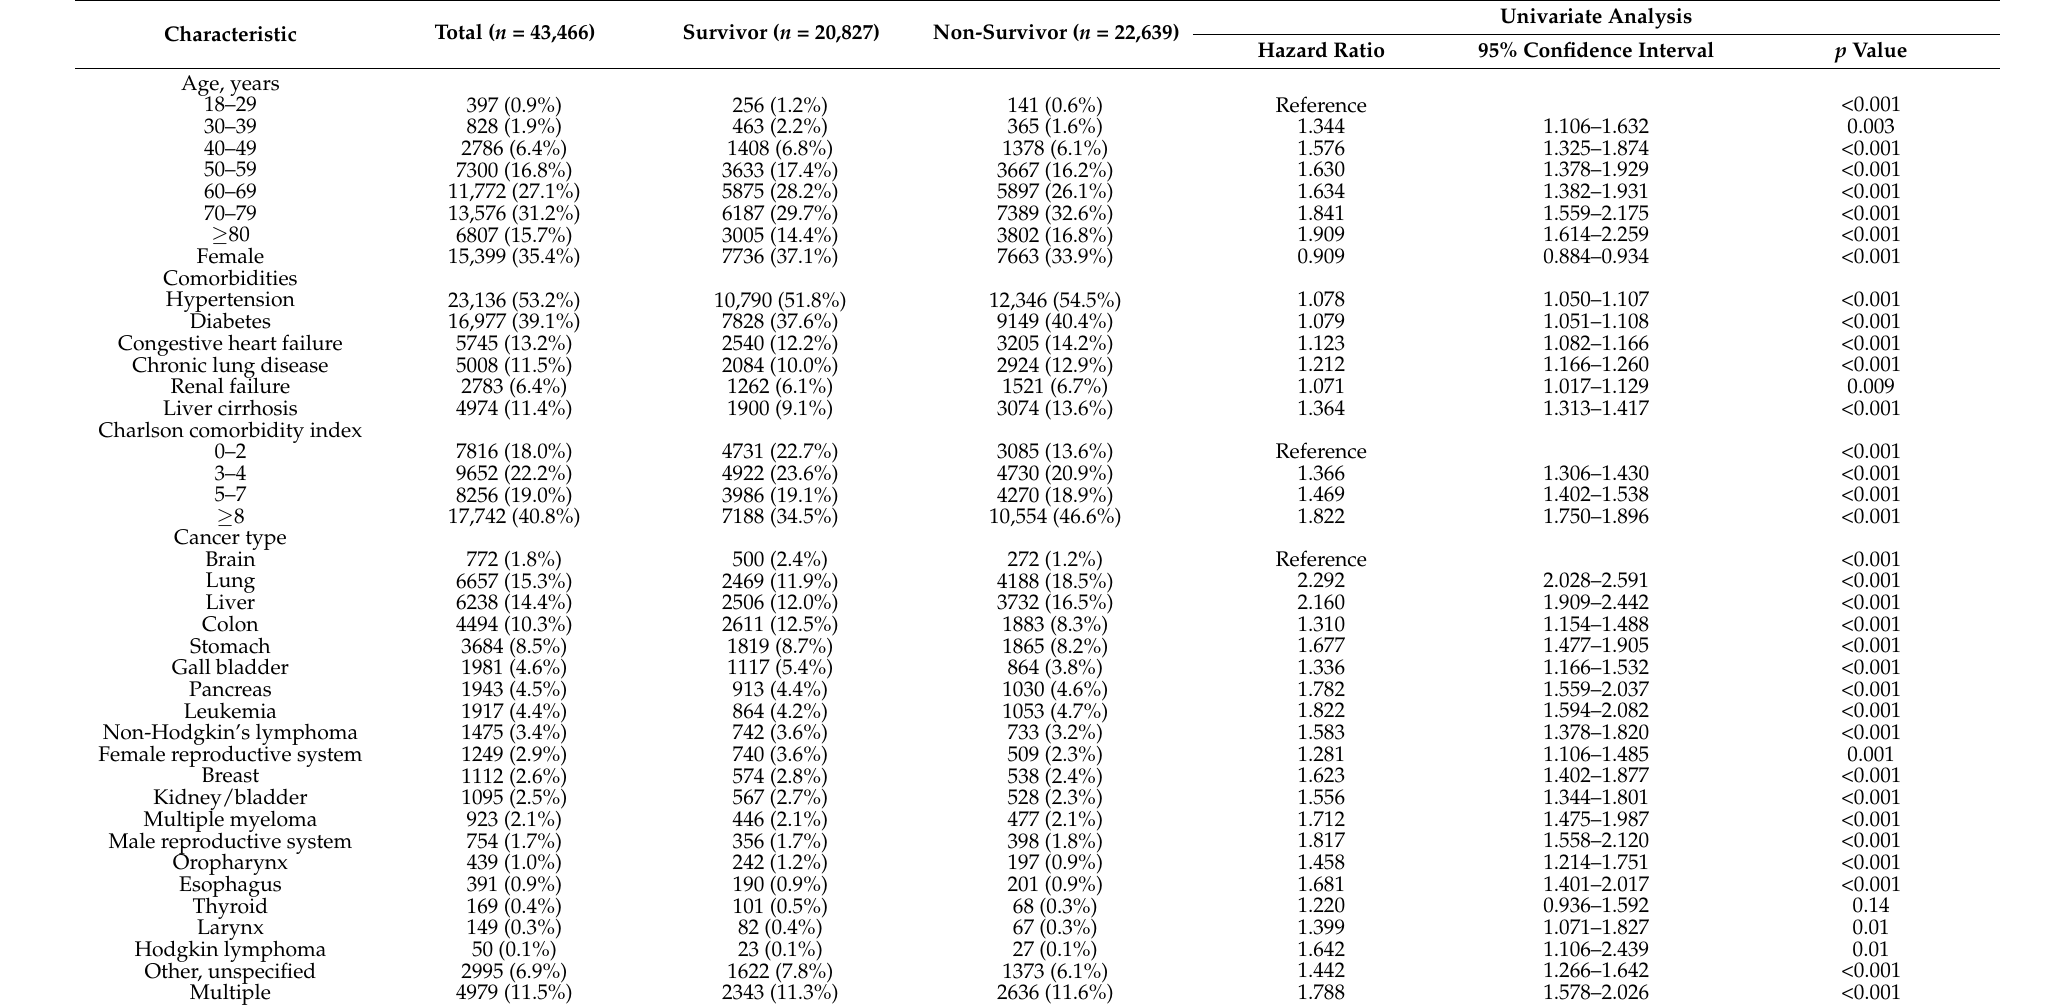
Table 1. Characteristics and hazard ratios for 30-day mortality among the study